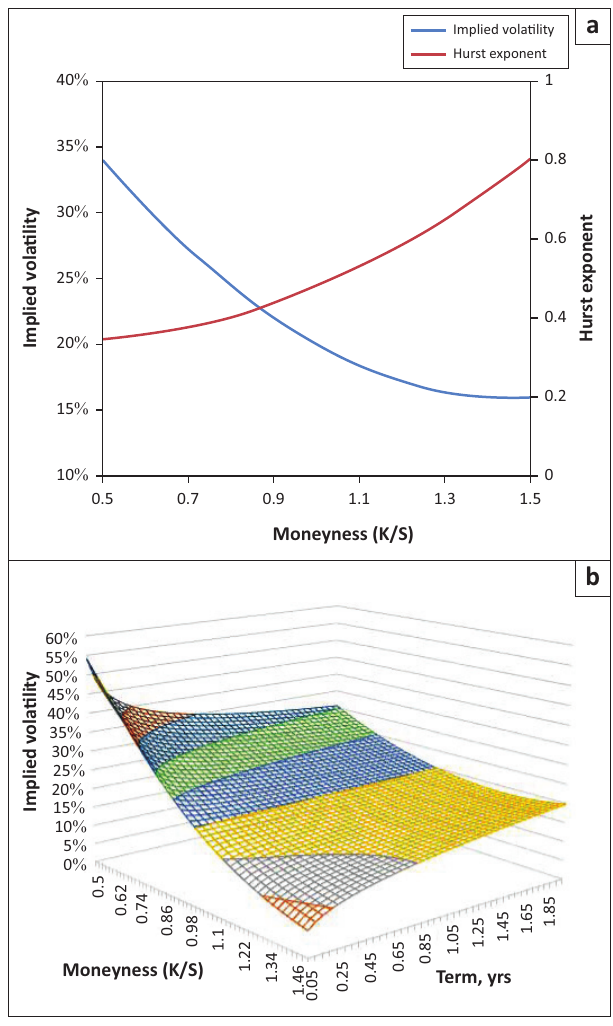
FIGURE 2: Indicative implied volatility surfaces for a given 1-year volatility skew for H = {0.4,